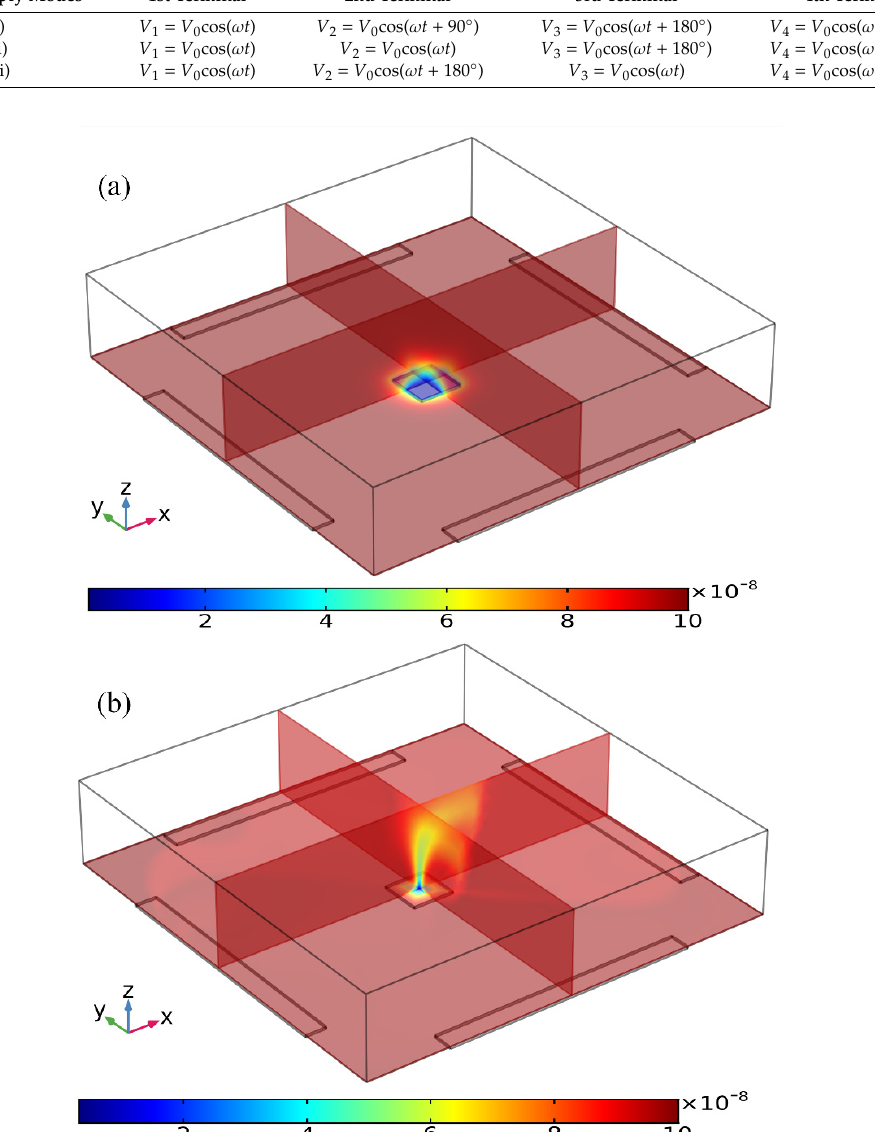
Figure 4. Simulation result of the volumetric concentration of suspended antigens on top of the binding surface at t = 100 s for the following two circumstances: ( a ) Concentration distribution of suspended antigens in the absence of any AC voltage supply with only analyte diffusive transport on the FE, leading to a thick depletion boundary layer. ( b ) The ROT-ICEO recirculating flow stirs effectively the depleted concentration after the peripheral DE array is powered by a four-phase AC voltage signal at V 0 = 8 V and f = 200 Hz.